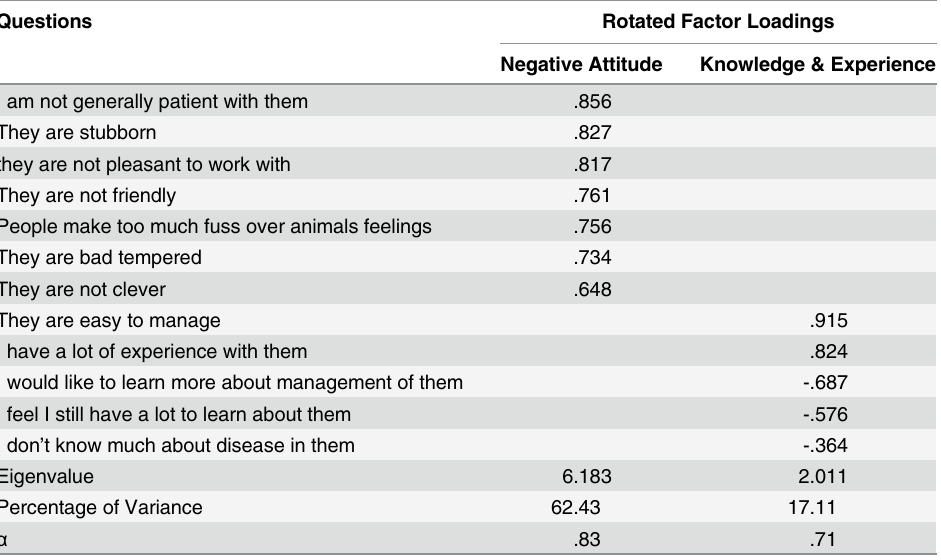
Table 3. Summary of the exploratory factor analysis results from all 27 keeper questionnaires. Show- ing the Pattern Matrix with principal axis factoring extraction method and an oblimin rotation with Kaiser Nor- malisation. The Eigenvalue, percentage of variance and Cronbach ’ s alpha score are also provided for the two